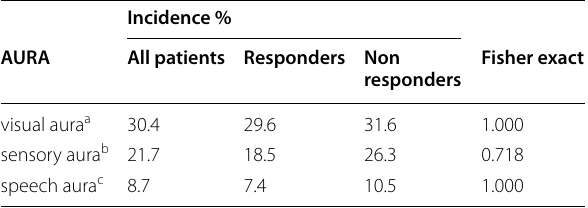
Table 5 Incidences of auras that were followed by headache prior to galcanezumab treatment